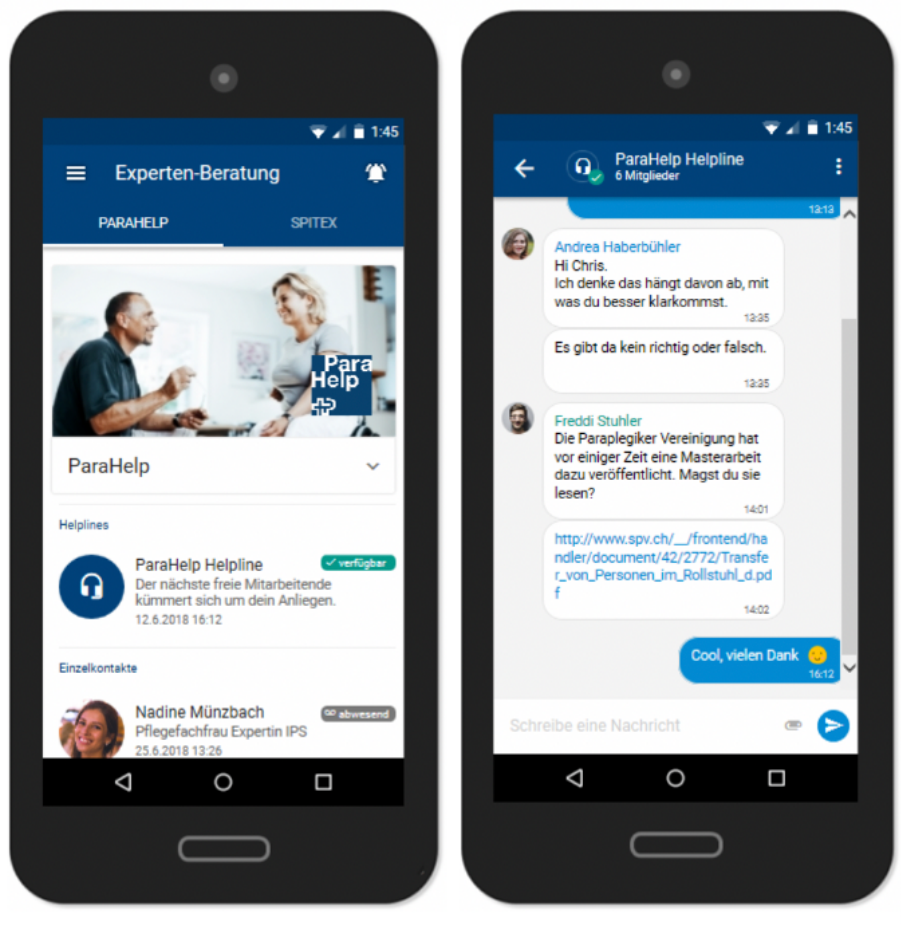
Figure 4. Expert